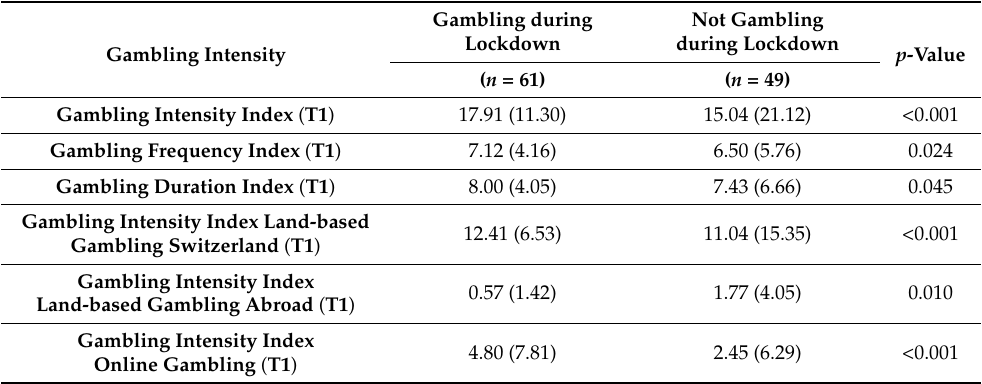
Table 5. Gambling participation during lockdown and previous gambling intensity.